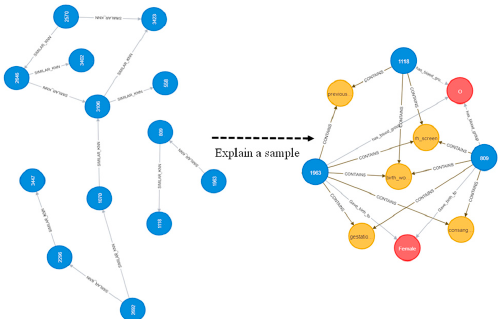
Figure 5. An example of the KNN algorithm showing the reason why patients are similar to each other.